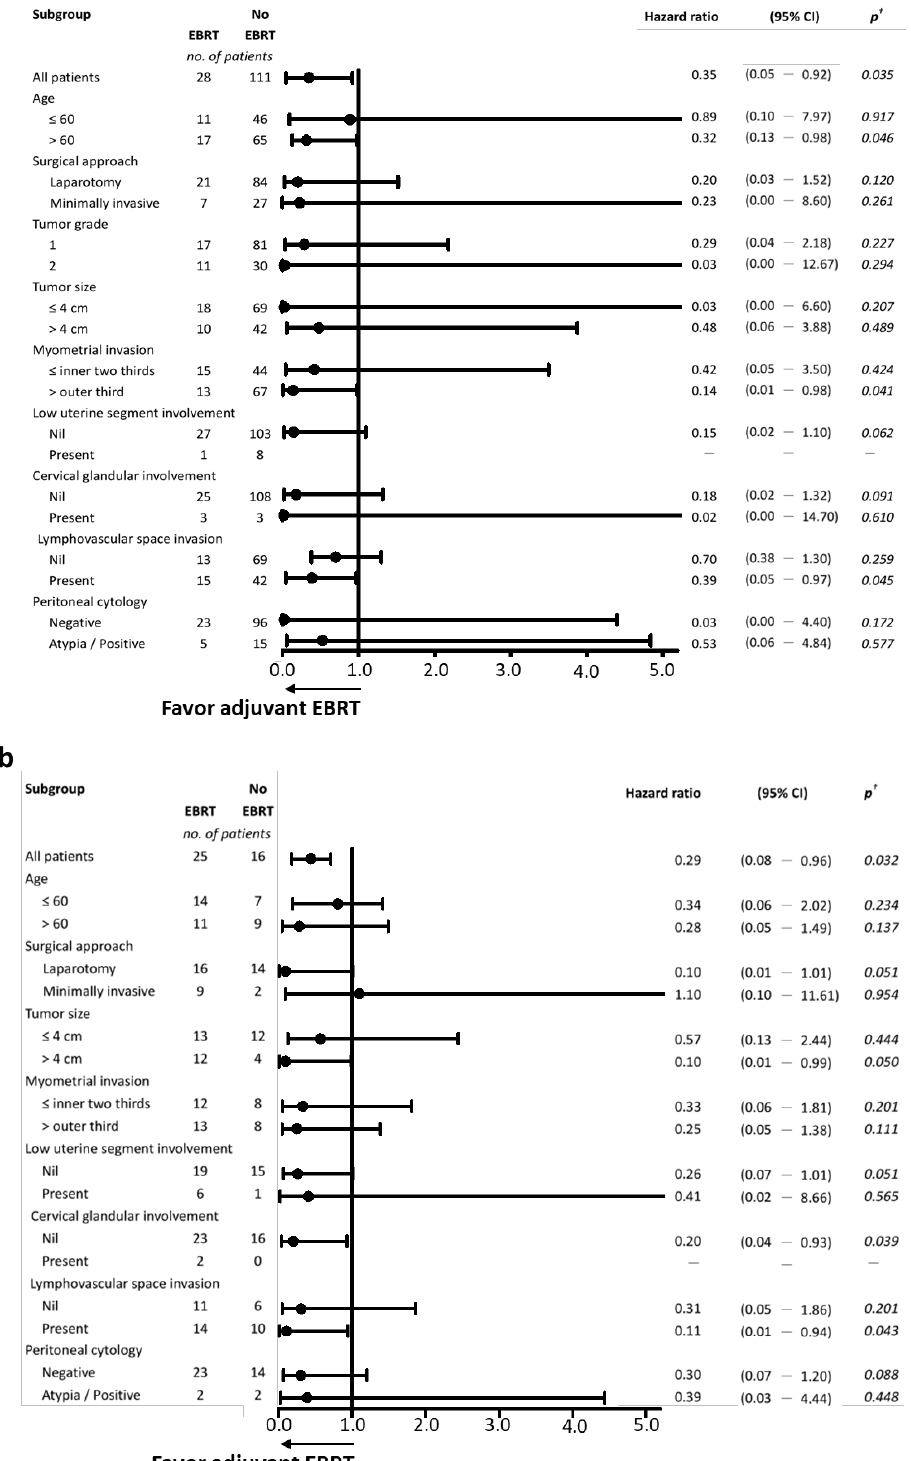
Figure 3. Subgroup analysis of prognostic factors for recurrence-free survival in patients with stage IB endometrial cancer by pathology grade. ( a ) Grades 1/2 ( n = 139); ( b ) grade 3 ( n = 41). Hazard ratios and 95% confidence intervals (CI)